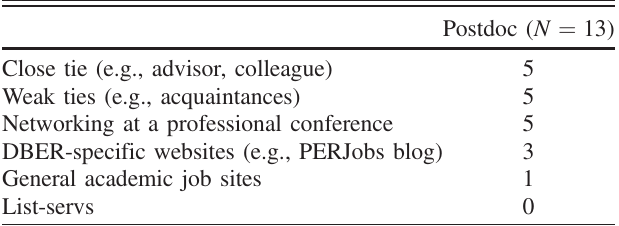
TABLE VI. How postdocs searched for positions. Interviewees used multiple methods, so the totals are much larger than the sample